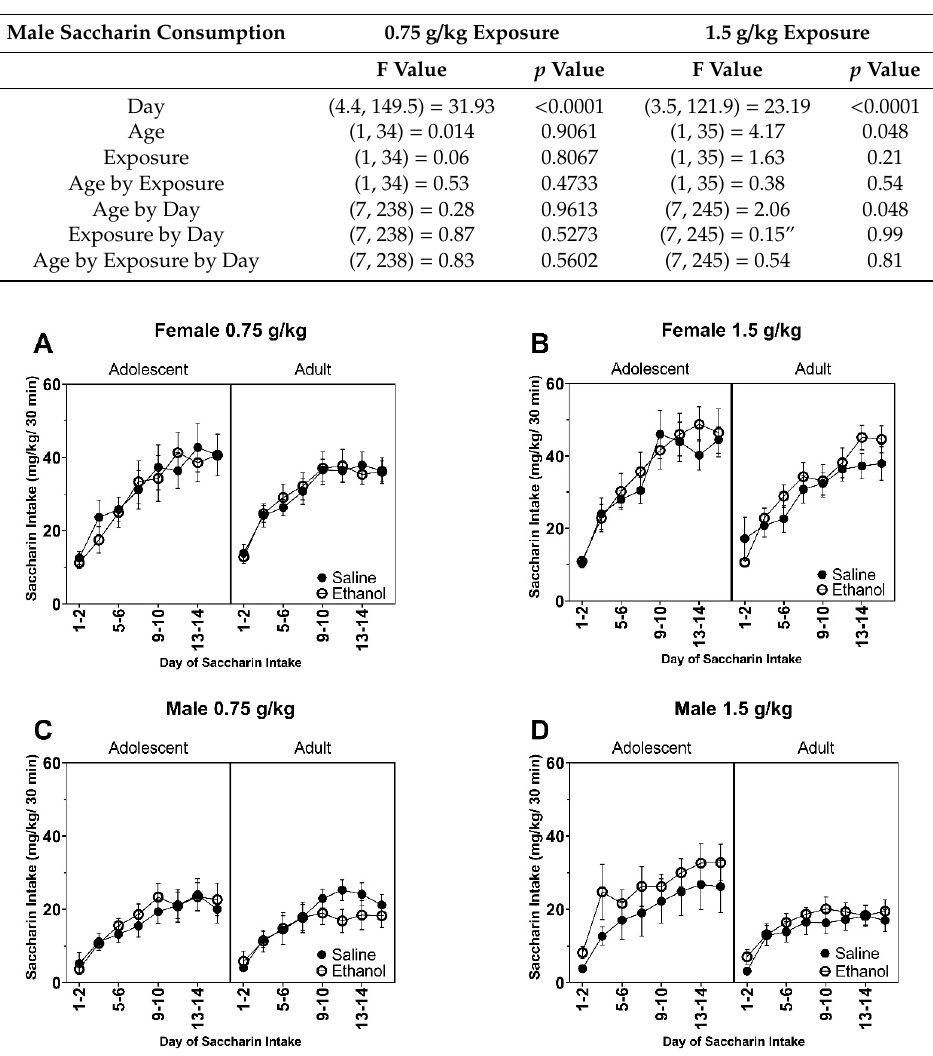
Figure 4. Data are presented as saccharin consumed (mL / kg) for the 30 m in session. Female rats chronically exposed to ( A ) 0.75 g / kg and ( B ) 1.5 g / kg. Male rats chronically exposed to ( C ) 0.75 g / kg and ( D ) 1.5 g /